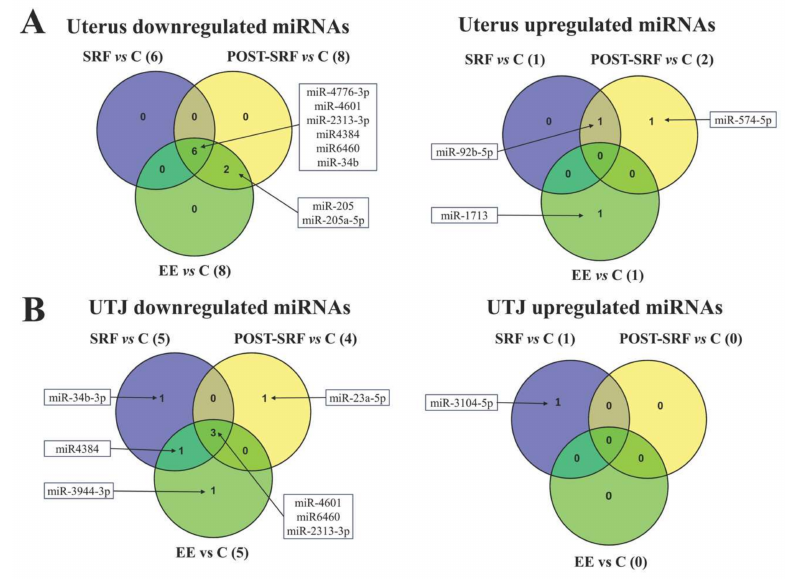
Figure 4. Venn diagram depicting the microRNAs (miRNAs) di ff erentially regulated (False Discovery Rate < 0.05 and ≥ 2.0-Fold Change or ≤− 2.0) and overlapped in the media of each incubated explant (uterus and utero-tubal junction (UTJ)) exposed to di ff erent treatment (Medium 199 (M199) supplemented with seminal plasma from di ff erent ejaculate fractions (sperm-rich fraction (SRF) and post-SRF) and the recomposed ejaculate (EE) compared with its control (C, M199 alone). ( A ) MiRNAs downregulated (left) and upregulated (right) in utero-culture medium. ( B ) MiRNAs downregulated (left) and upregulated (right) in UTJ-media.